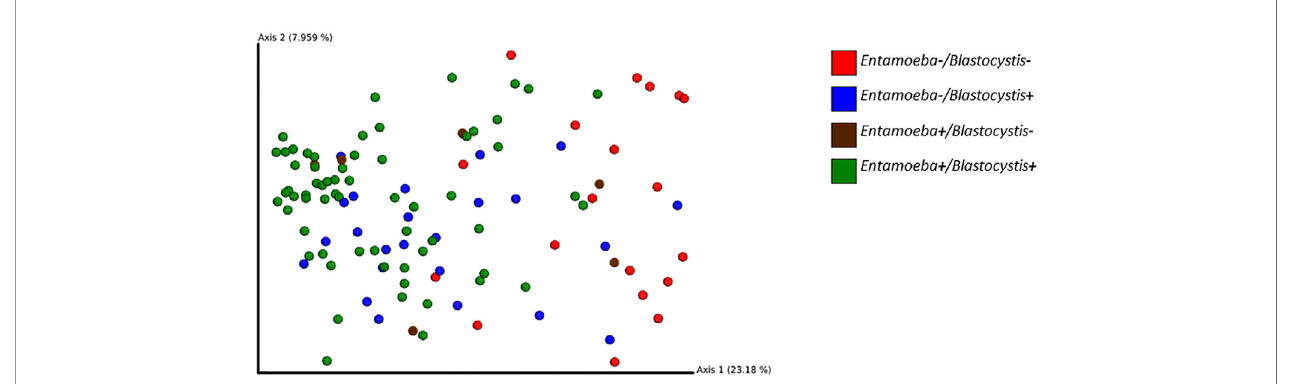
FIGURE 7 | 2D EMPeror beta diversity plot snapshot representing the fi rst two principal components of the PCoA analysis (unweighted Unifrac matrix).